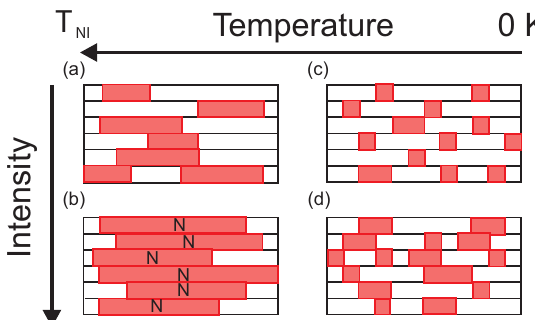
Figure 33. Size of the photo-generated domains at vicinity of T NI . ( a ) At low laser intensity, the domain size is small compared to ( b ) high laser power; ( c ) When temperature is reduced the domain size is smaller and ( d ) almost independent of the laser